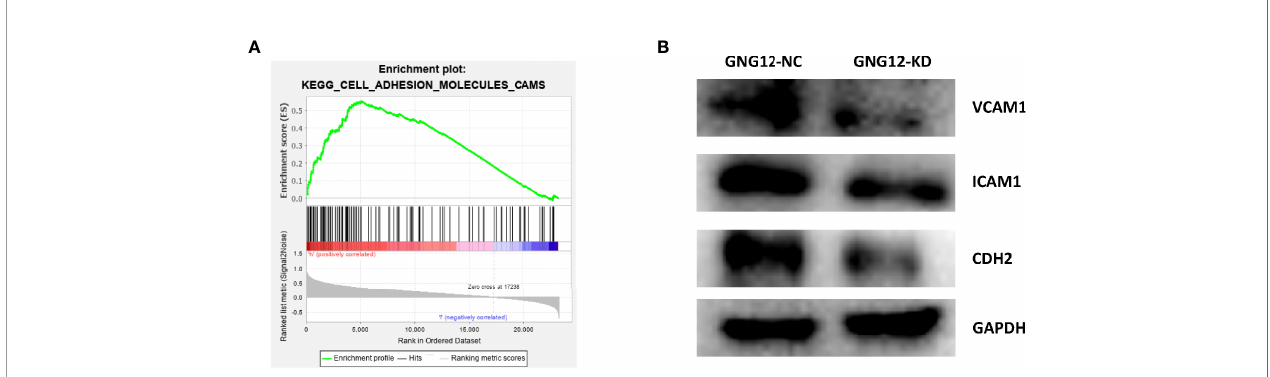
FIGURE 7 | The involvement of GNG12 in the regulation of cell adhesion molecule signaling pathway. (A) Analysis of the signi fi cant enrichment of GNG12 in cell adhesion molecule signaling pathway based on GSEA. (B) Western blotting assay to detect the effect of knockdown of GNG12 on the expression of VCAM-1,